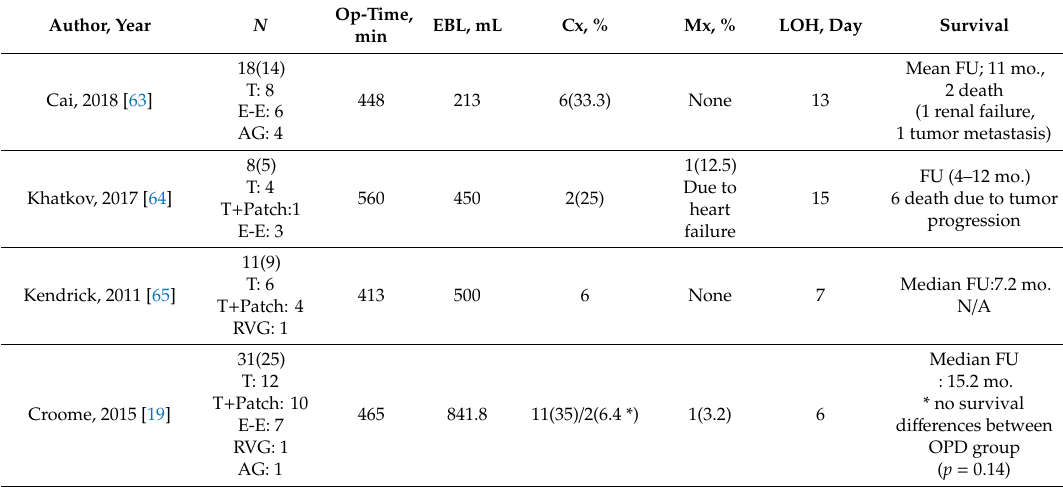
Table 4. Summary of articles reporting more than 5 cases of LPD-venous vascular resection (LPD-VR) for pancreatic